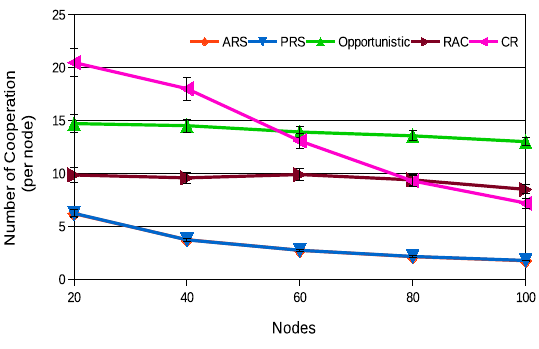
Figure 13. Average number of cooperation exchanges for a dynamic scenario.